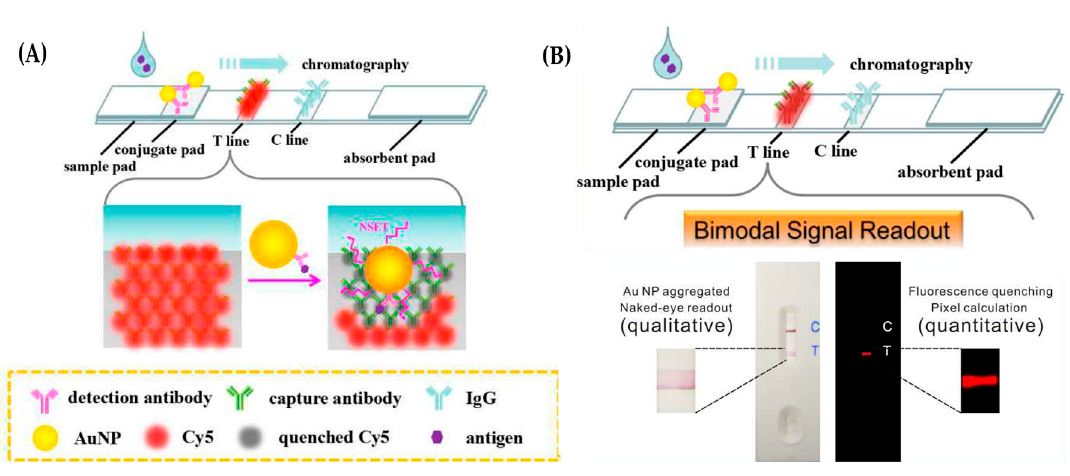
Figure 6. Dual Signal output lateral flow assay for the detection of carcinoembryonic antigen. ( A ) Mechanism of fluorescence quenching signal output for antigen quantification; ( B ) Visual (qualitative) and fluorescence output (quantitative) for clinical detection. Adapted from [95].